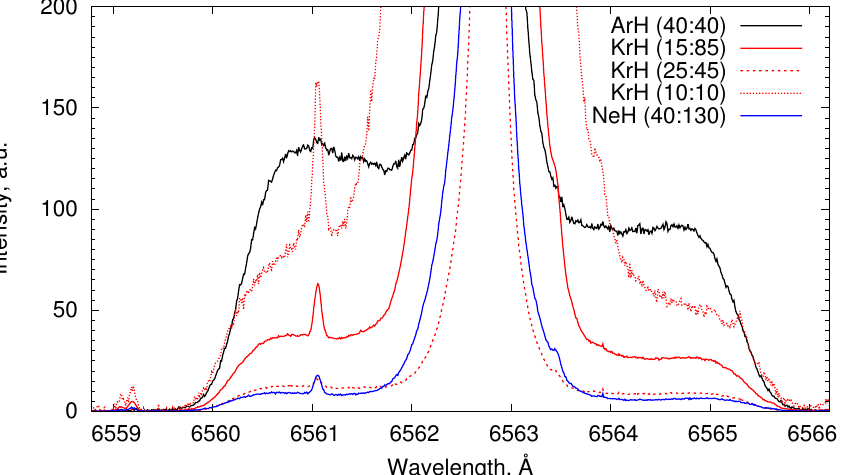
Figure 12. Example of the emission of reflected atoms in ArH, KrH, or NeH plasmas. black curve: ArH ( F Ar = 40 sccm, F H = 40 sccm, p = 0.039 Pa); red curve: KrH( F Kr = 15 sccm, F H 2 p = 0.041 Pa); dashed red curve: KrH( F Kr = 25 sccm, F H KrH( F Kr = 10 sccm, F H = 10 sccm, p = 0.039 Pa); blue curve: NeH(( F Ne = 40 sccm, F H 2